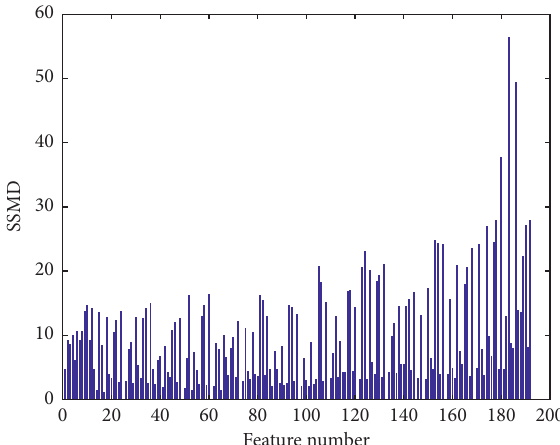
Figure 4: The SSMD of 192 statistical features of the training samples.